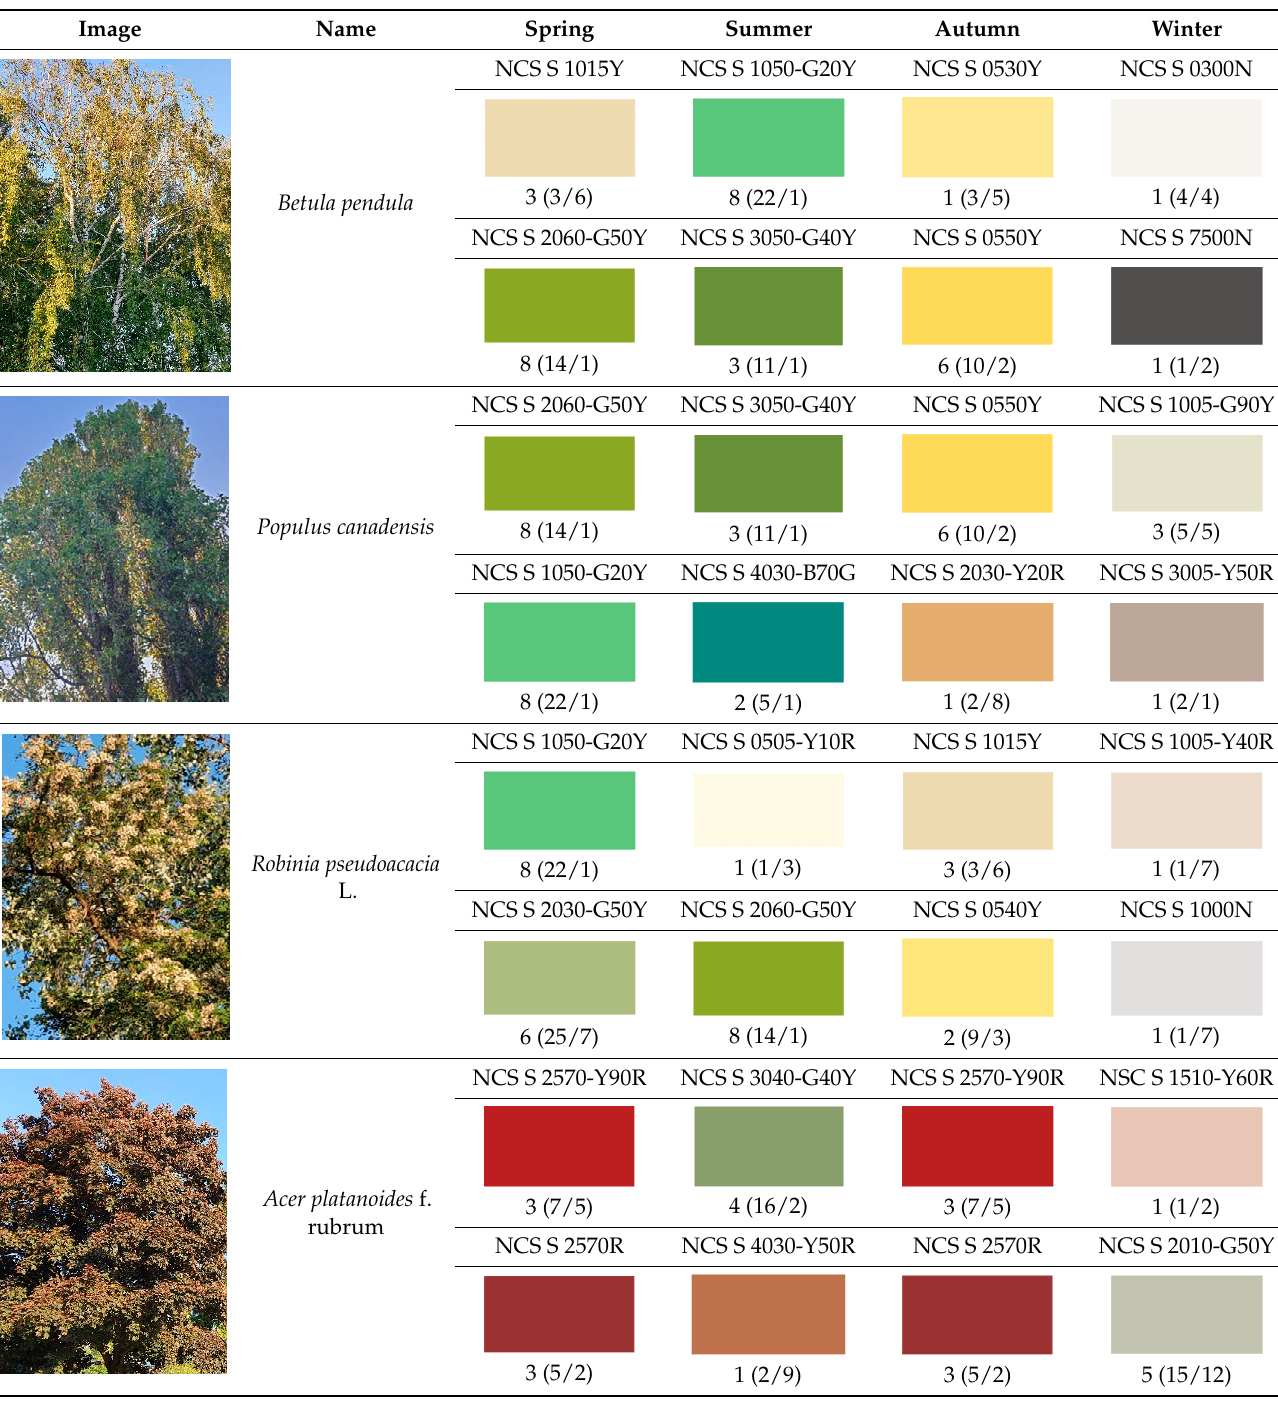
Table A1. Eighty-eight color samples taken from trees identified in the research area. The numbers below the color sample provide the information how many times a given color appears in the table (how many times it appears in all natural samples/how many times it appears in the analyzed architectural objects). Image.